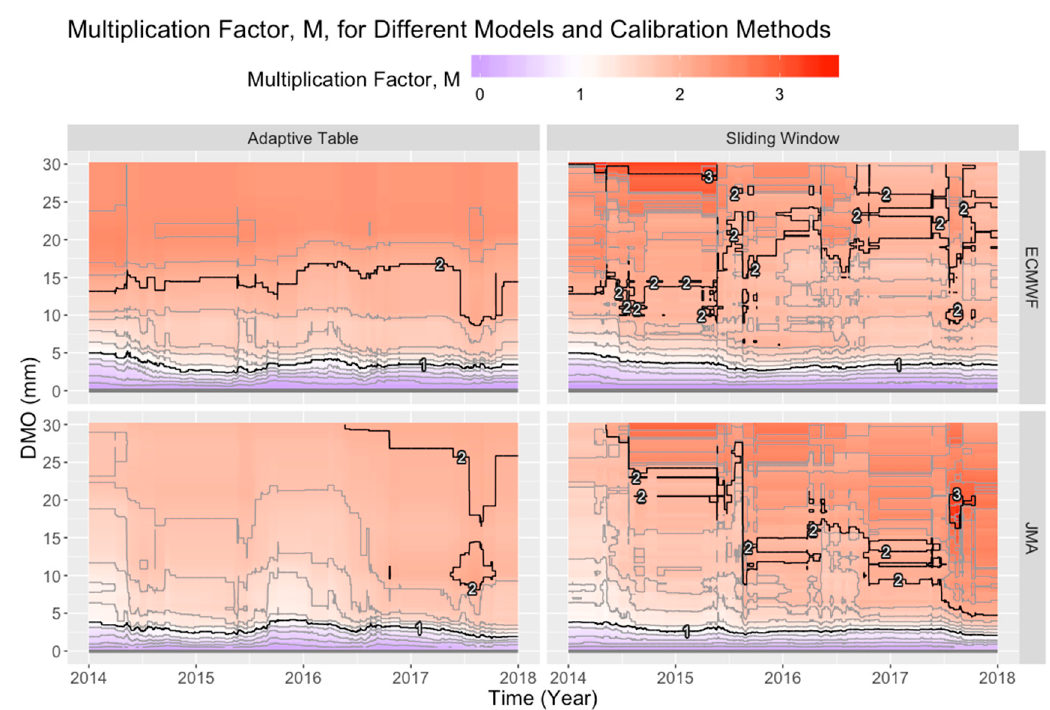
Figure 2. The multiplication factor, M , against Direct Model Output (DMO) and time, by calibration method and by model. Grey and black contours are in intervals of 0.2 and 1.0 respectively, starting from 0 at the bottom.